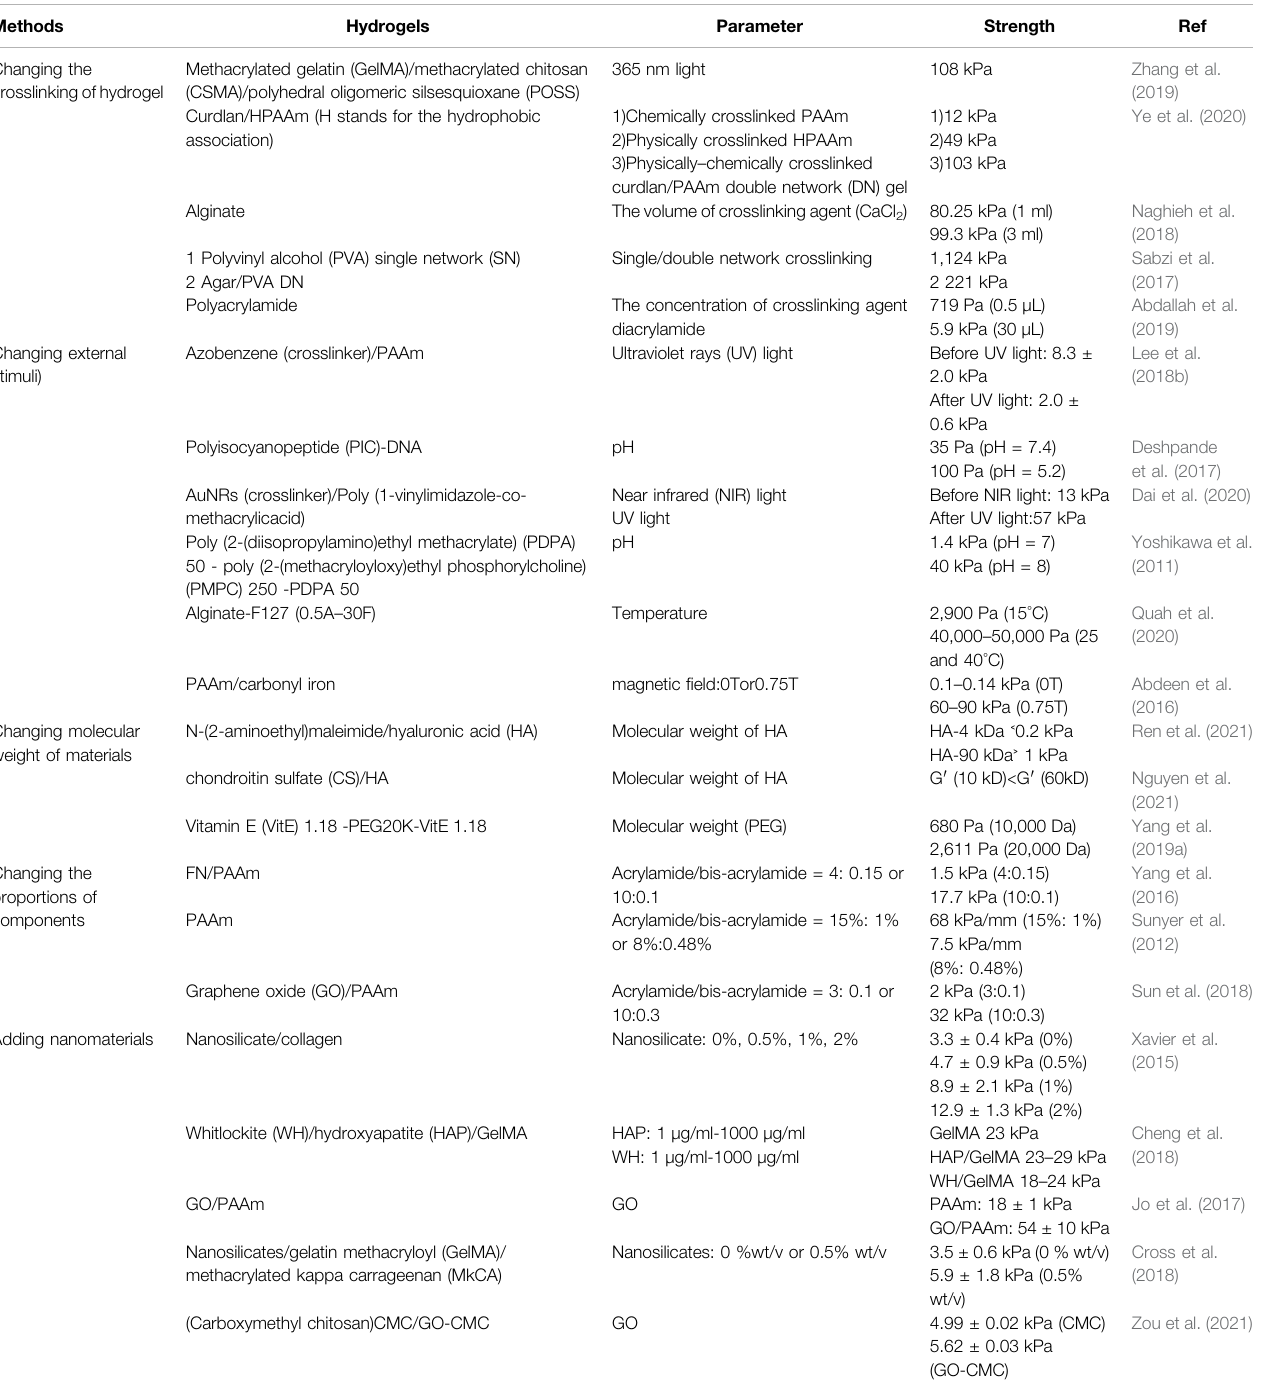
TABLE 1 | Summary of the hydrogels with different stiffness by different design